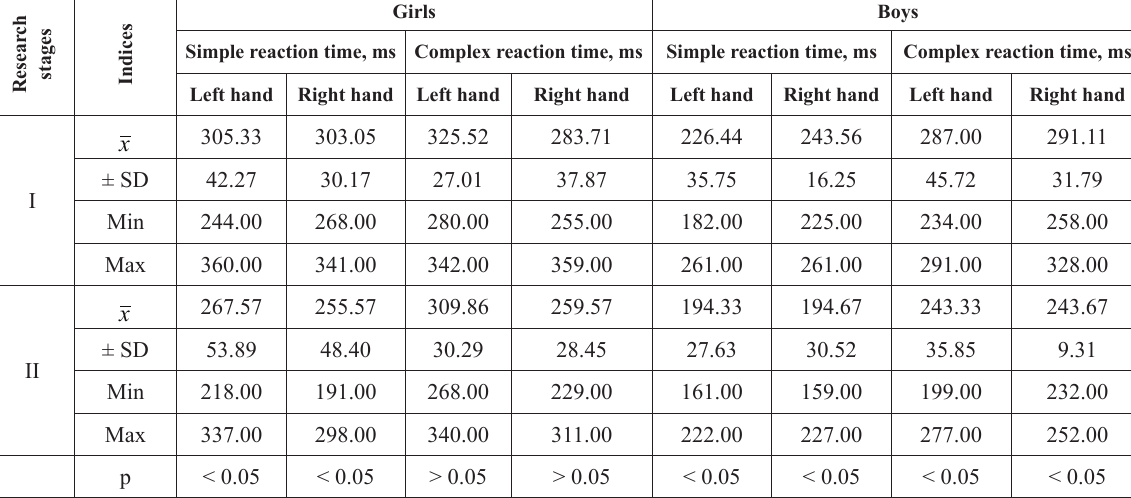
Figure 4. Indices of standing on the front foot of one leg for boys